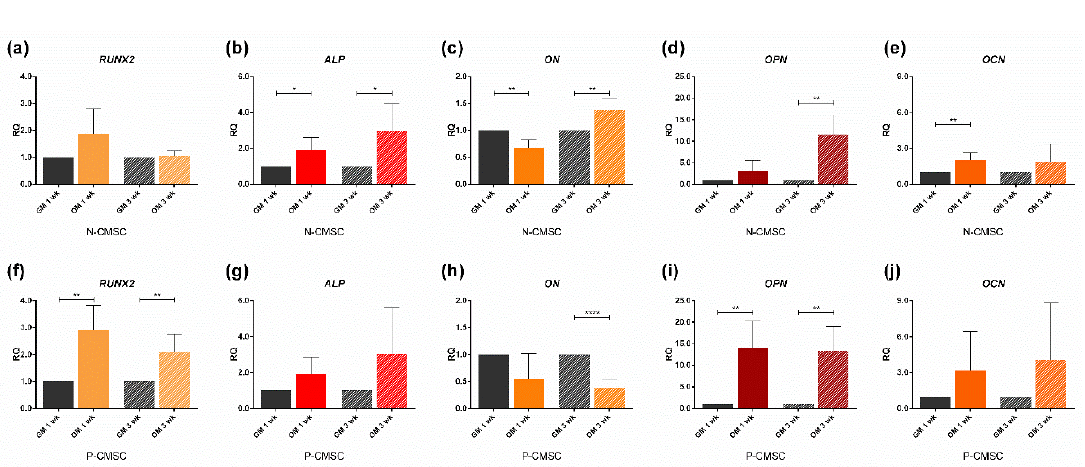
Figure 5. Expression profiles of osteo-specific genes. Transcript levels of: ( a , f ) RUNX2 ; ( b , g ) ALP ; ( c , h ) ON ; ( d , i ) OPN ; and ( e , j ) OCN , evaluated by qPCR in N-CMSC and P-CMSC, respectively, cultured with osteogenic medium (OM) for one (1 wk) and three weeks (3 wk). Cells cultured in standard growth medium (GM) were tested as controls at each time point. RQ, Relative Quantity (see Methods for details). * p < 0.05; ** p < 0.01; **** p < 0.0001.